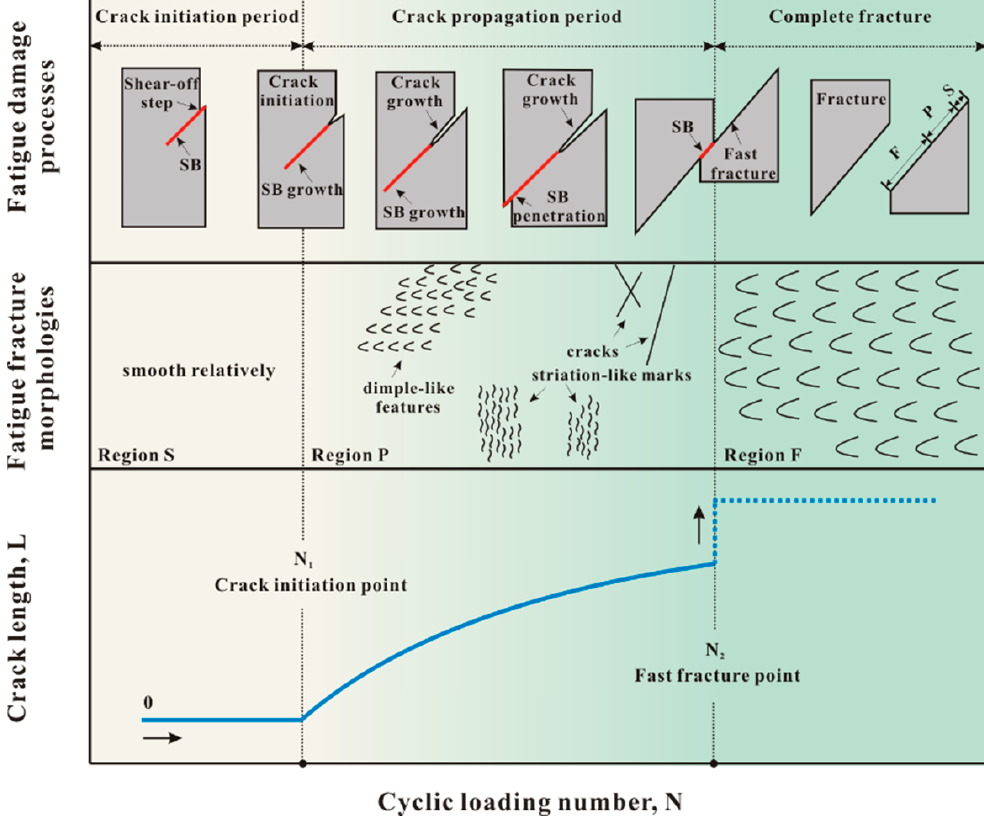
Figure 3. Comprehensive diagram of the shear band-mediated fatigue mechanism of MG [42].